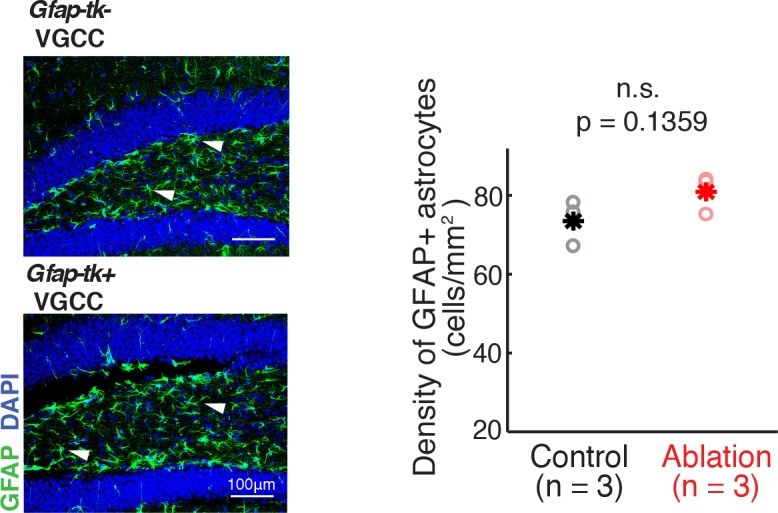
VGCC administration in ablation mice does not affect the density of GFAP astrocytes in the hippocampus.Left: GFAP immunostaining of astrocytes in the dentate gyrus of control mice (upper panel) and ablation mice (lower panel) after 8 weeks of continuous treatment of VGCC. Arrowheads show examples of GFAP astrocyte cell bodies. Green: GFAP; Blue: DAPI. Right: No significant difference in the density of GFAP astrocytes in VGCC-administered control mice (n = 3, black) and ablation mice (n = 3, red) (mean ±S.E.M.; p=0.1359, Wilcoxon rank sum test). Asterisks represent means.